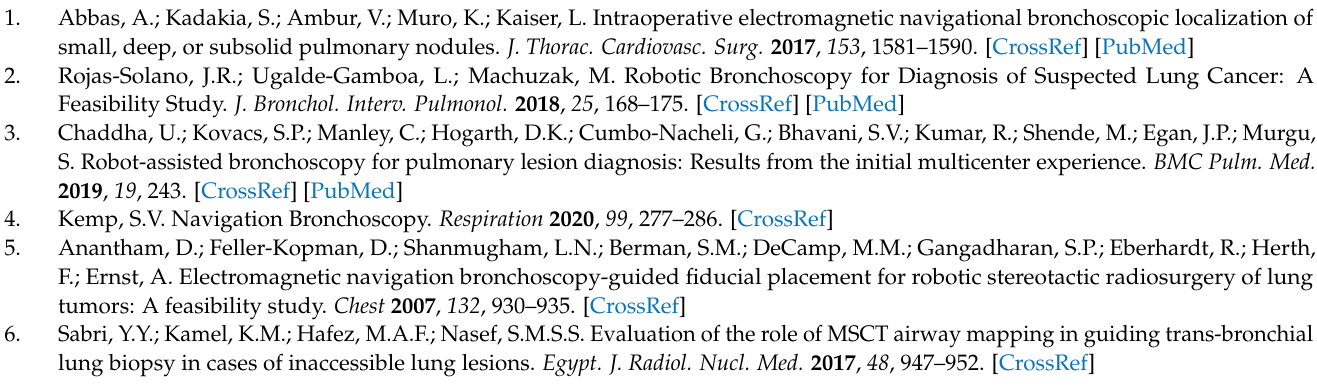
different media. Figure S4: Molecular structure and absorption peak of IR-780. Figure S5: The scheme of lung airways, generations, and bronchus diameters. Table S1: The fluorescence imaging depths in lung tissues with ICG gels of different concentrations as the imaging contrast. References [43,44] are cited in the supplementary